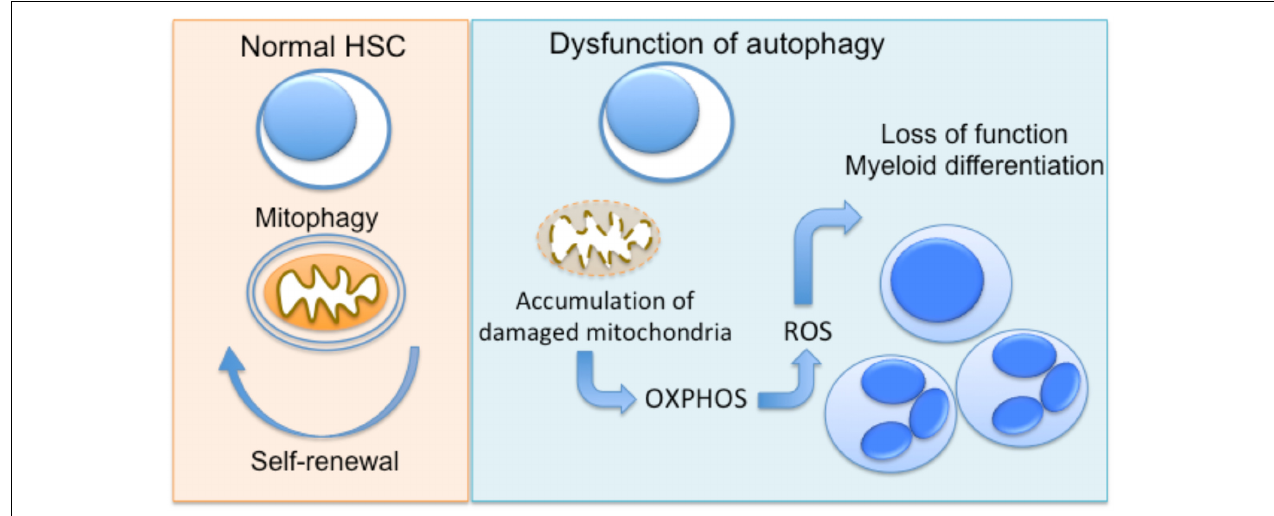
FIGURE 1 | Autophagy regulates hematopoietic progenitor function. In normal hematopoietic stem cells (HSC), autophagy enables the clearance of damaged mitochondria (mitophagy), promoting the maintenance of HSC function. Dysfunctional autophagy, due to deficiency of autophagy genes Atg7 or Atg12 in mice has been linked to accumulation of mitochondria and metabolic reprogramming toward OXPHOS. This results in functional decline and differentiation toward myeloid lineage.